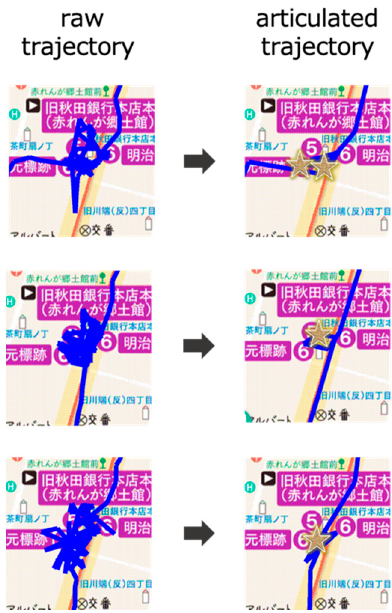
Figure 15. Examples of effectiveness in articulated trajectory mapping. User experiments for testing articulated trajectory mapping reveal its ability to be reviewed and played back after walking tours.